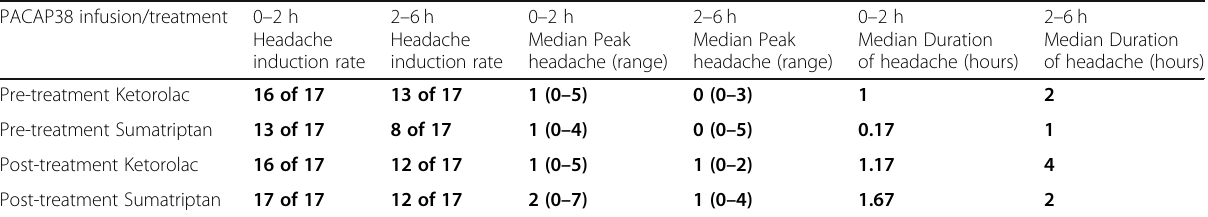
Table 1 Headache incidence and characteristics after PACAP38 infusion and treatment with ketorolac and sumatriptan from 0 to 2 and 2 – 6 h. Headache inductions rate: number of participants who developed headache; Median peak headache: peak headache intensity recorded on a numerical rating scale from 0 to 10 PACAP38 infusion/treatment